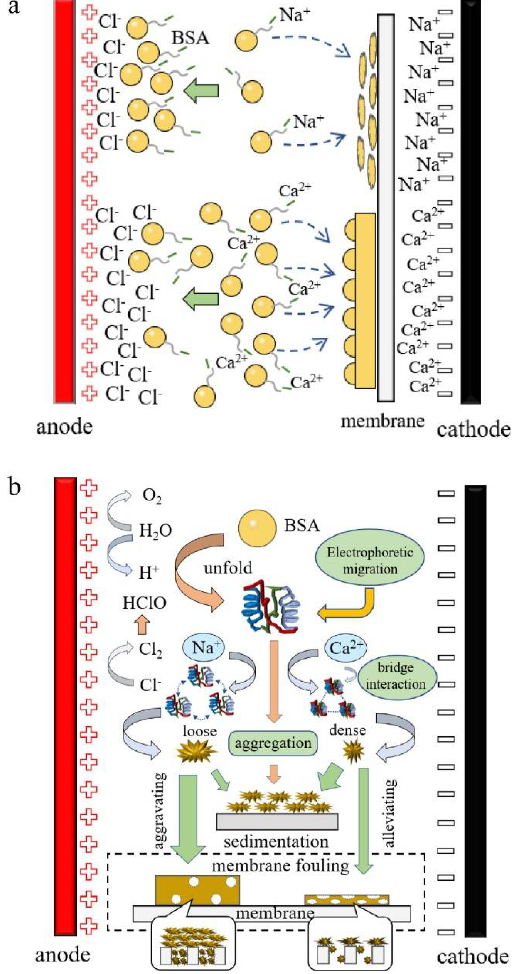
Figure 17. Schematic explanation of the suggested processes for membrane fouling development in the presence of various cations (Ca 2+ or Na + ) in the EFMF system at 1.5 V ( a ) and 3 V ( b ) [109].